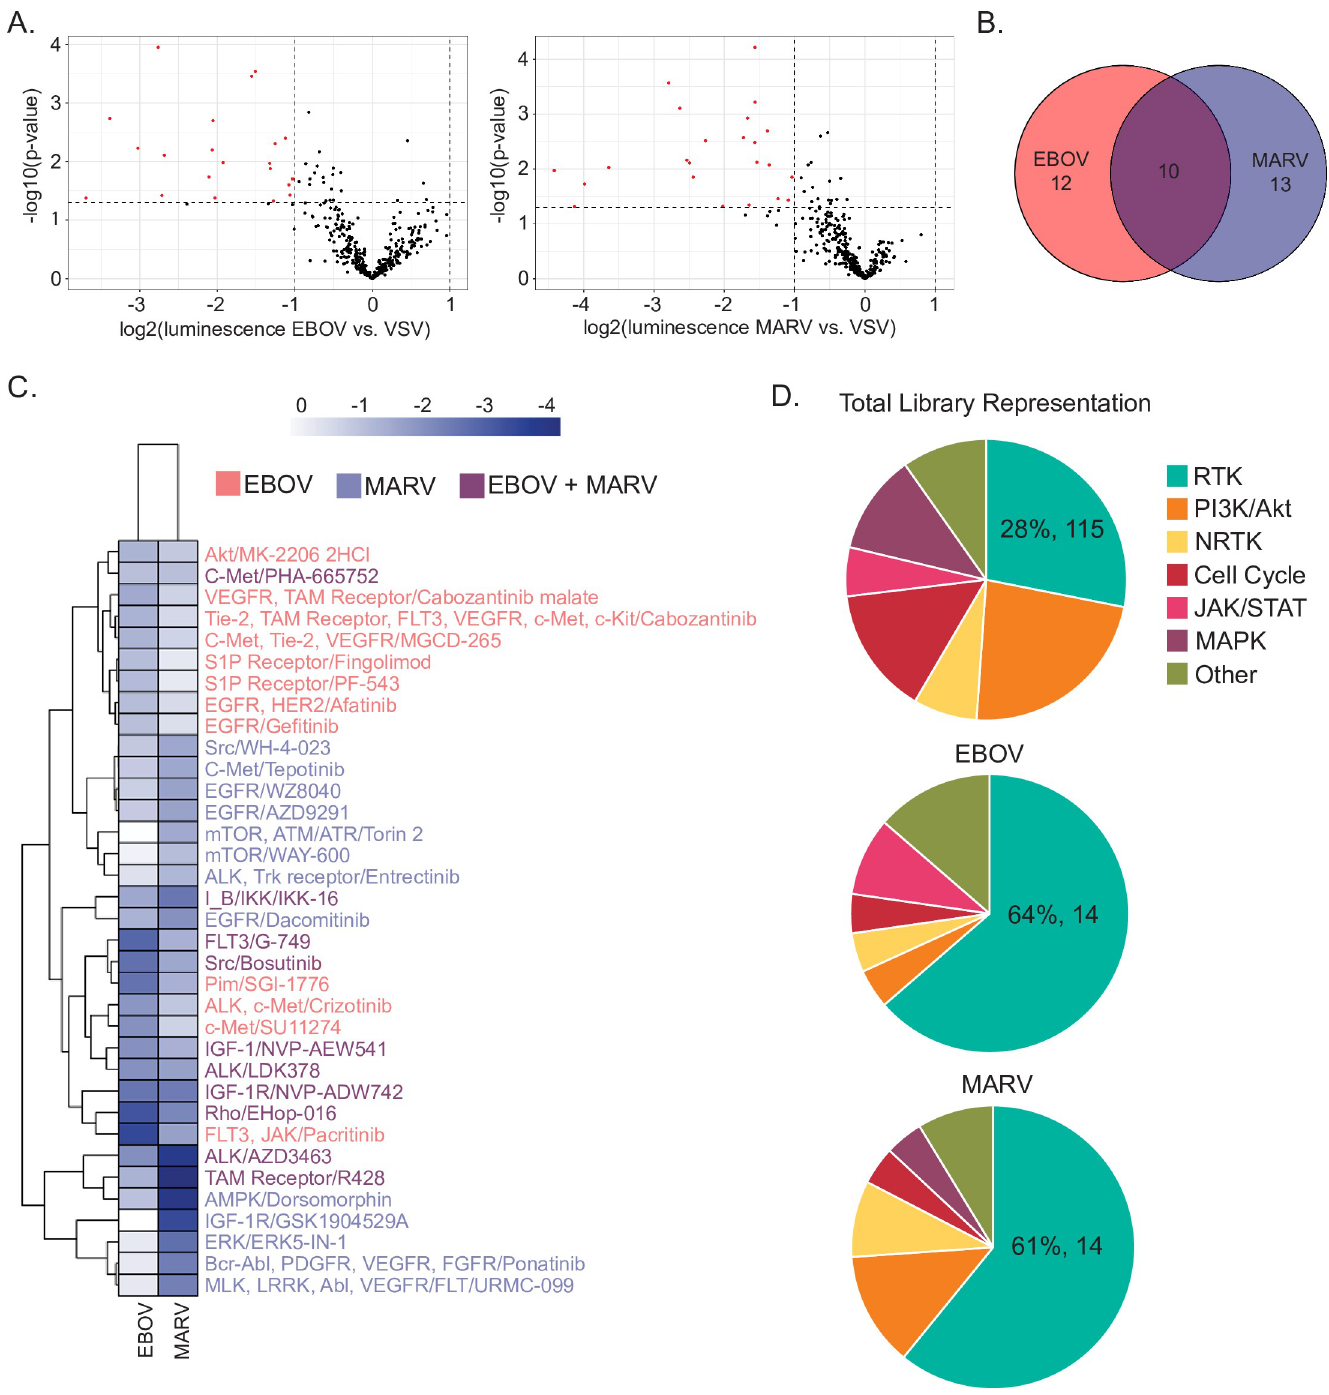
Fig 1. A kinase inhibitor screen to identify signaling pathways required for EBOV and MARV GP-mediated entry. MLV pseudotypes encoding LacZ and harboring EBOV, MARV, or VSV glycoproteins were used to screen the Selleckchem L1200 kinase inhibitor library at 1 μ M in Vero cells (A) Volcano plots of the log2 values of the ratios of the means of biological replicates of EBOV (left panel) or MARV (right panel) vs VSV pseudotype transduction relative to the DMSO controls over the–log10 values of the p-value. Dots in red represent hits as determined with at least 2-fold ratio and p < 0.05. Results are means of three independent experiments performed in duplicates. (B) Venn diagram of the hits for EBOV and MARV, with 22 total hits for EBOV, 23 total hits for MARV, and 10 hits shared between the two viruses. (C) Heat maps of the log2(normalized transduction efficiency of EBOV or MARV vs. that of VSV) for the total hits for both viruses. (D) Pie charts of the signaling pathways (grouped into the following categories: receptor tyrosine kinase (RTK) inhibitors, Janus kinase/signal transducers and activators of transcription (JAK/STAT) pathway inhibitors, mitogen-activated protein kinase (MAPK) pathway inhibitors, non-receptor tyrosine kinase (NRTK) inhibitors, and